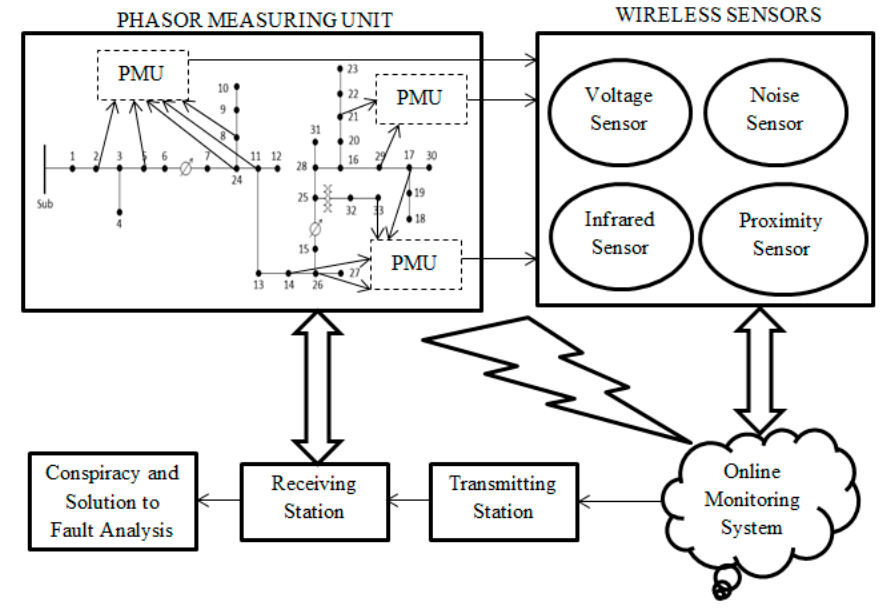
Figure 1. Incorporation of sensors with Phasor Measuring Units (PMU) for fault detection .